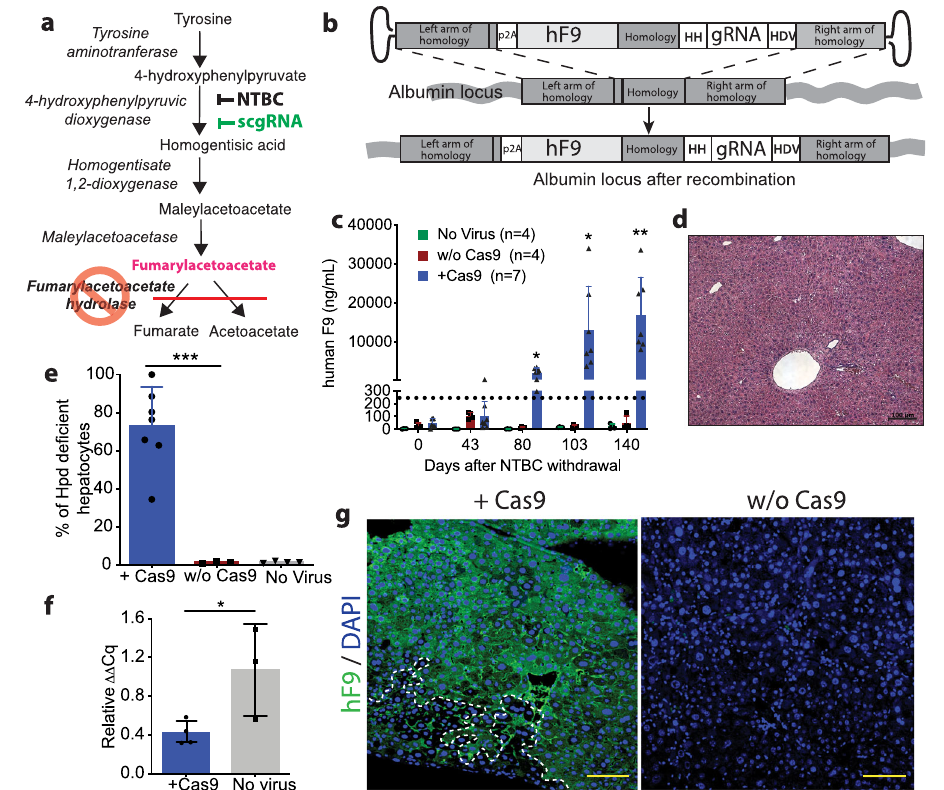
Fig. 1 | Use of the scgRNA for selection of GR-targeted hepatocytes. a The tyr- osine catabolic pathway. Fah − / − mice lack the ability to metabolize fumar- ylacetoacetate, resulting in hepatotoxicity. By inhibiting the upstream enzyme 4-hydroxyphenylpyruvate dioxygenase (Hpd) with either the drug NTBC or a scgRNA against Hpd , fumarylacetoacetate isnot produced. b Schematic of the GR- Hpd scgRNArAAVvectoranditsintegrationintotheAlbuminlocusbyhomologous recombination.The rAAVvectorcontains arms of homologyto the Albumin locus, a P2A, and a scgRNA (HH-gRNA-HDV). hF9: human Factor 9; HH: hammerhead ribozyme; gRNA: guide RNA targeting Hpd ; HDV: hepatitis delta virus ribozyme. Day 80 P =0.012; Day 103 P =0.046; Day 140 P =0.008 ( c ) hF9 concentrations in Fah -/- mice treated with ~1×10 14 vg/kg GR- Hpd scgRNA rAAV that did or did not receive ~8×10 12 vg/kg rAAV-spCas9 following NTBC withdrawal. Dashed line indi- cates therapeuticF9threshold. Biologically independentmicewere analyzed. Data are presented as mean values and error bars represent standard deviation.